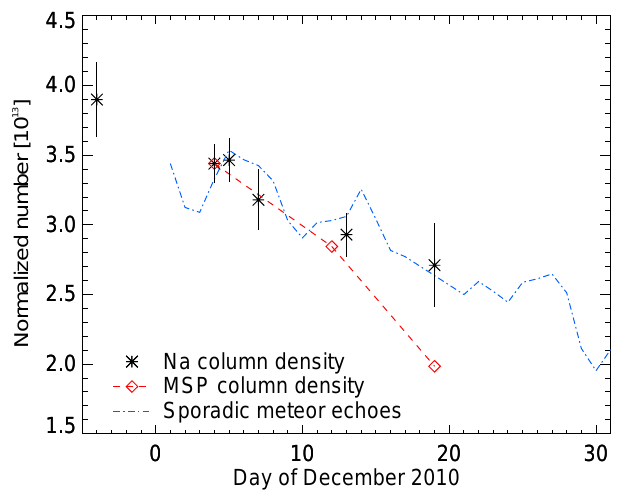
Figure 10. Comparison of sporadic meteor echoes (blue dash-dot line), Na column density (black asterisks; error bars indicate the standard deviation of the geophysical variability), and MSP col- umn (red diamonds) in December 2010. The y axis is correct for Na column density in m − 2 . The values must be multiplied by 1 . 51 × 10 − 2 for absolute MSP column density. The values multi- plied by 2 . 5 × 10 − 10 give the correct number of observed sporadic meteor echoes. The number of meteor echoes on 17 to 19 December is interpolated, because the radar was out of order on these